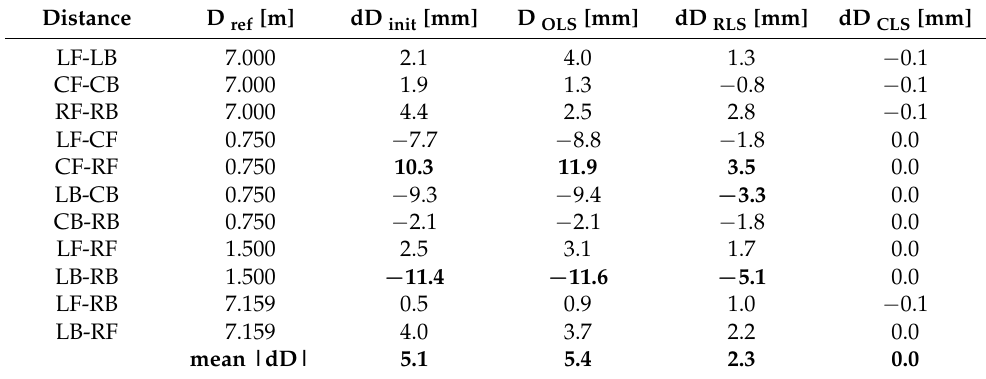
Table 3. The differences in distances in relation to the theoretical frame fixed values.